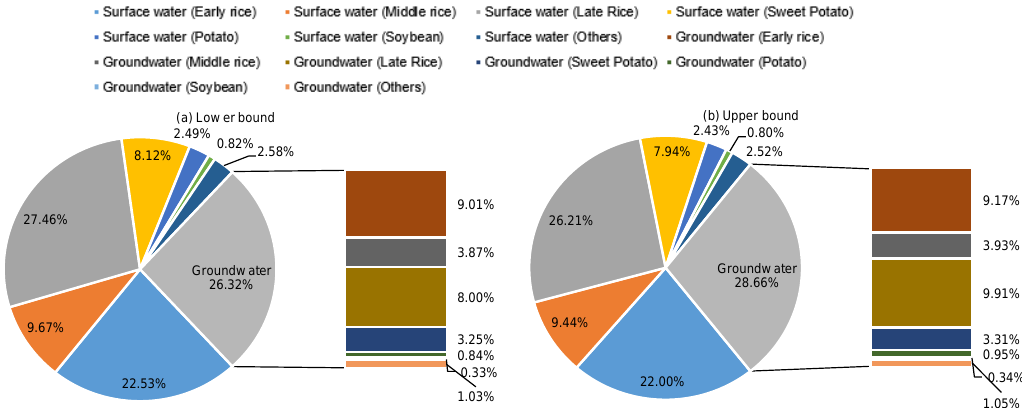
Figure 7. Water resources allocation: ( a ) Lower bound, ( b ) Upper bound.